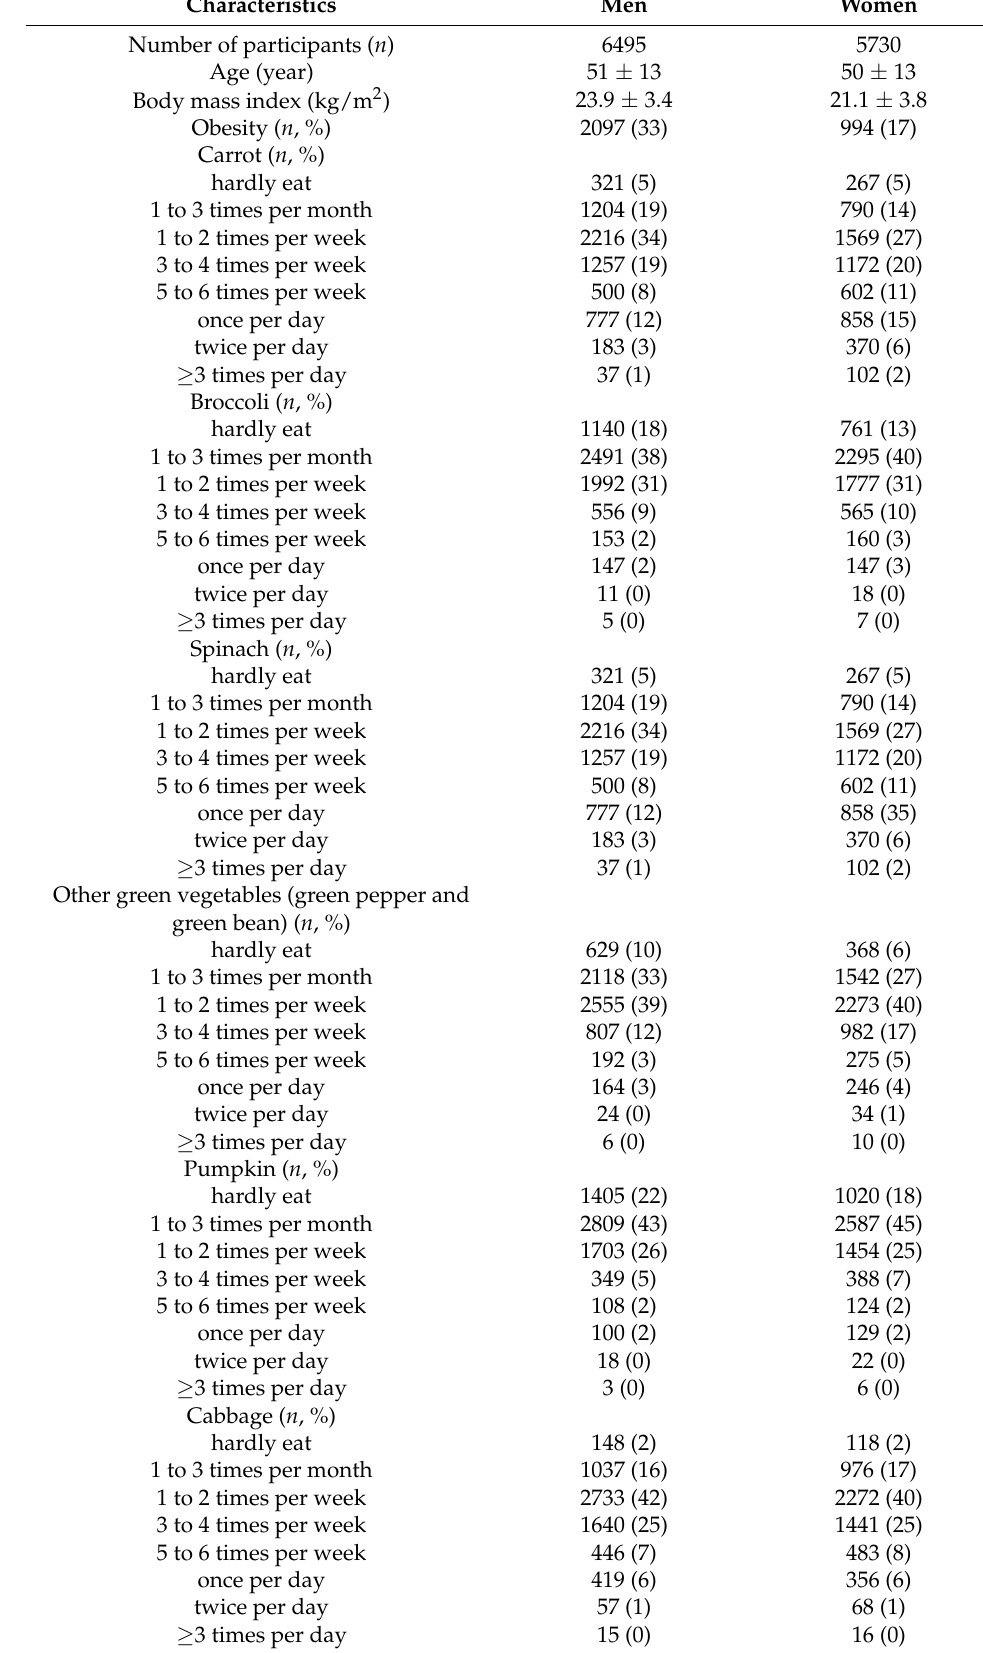
Table 1. Characteristics of study participants and frequency of vegetable